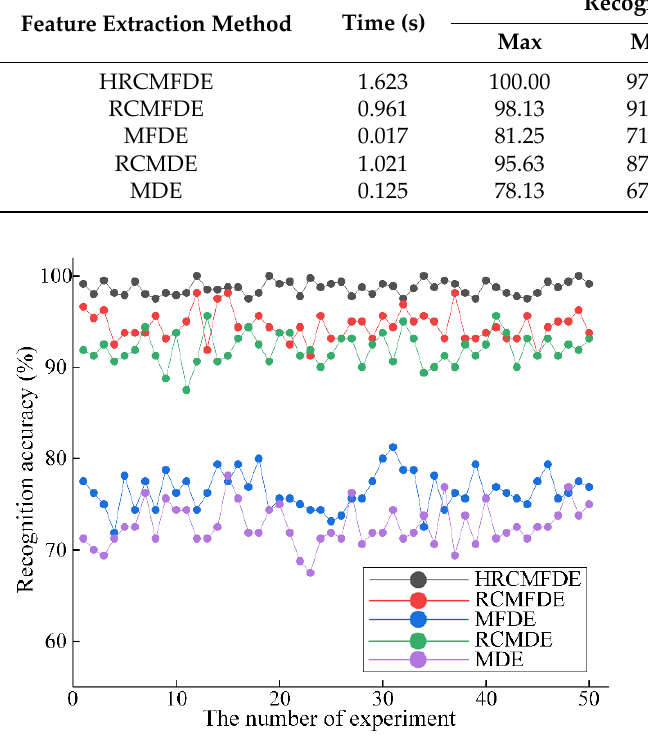
Figure 13. The accuracy of different approaches.